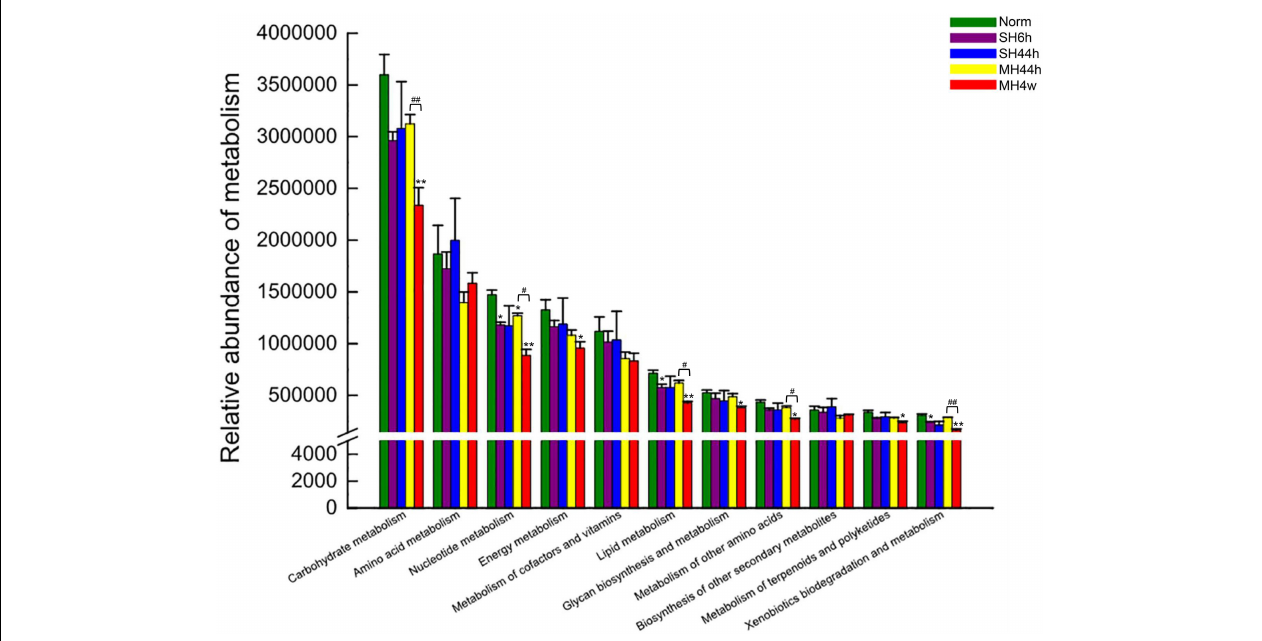
FIGURE 3 | Functional prediction of metabolism between hypoxia treatment groups and normoxia. Bars indicate the mean ± SD. Statistical symbols: * P < 0.05 and ** P < 0.01 between normoxia and hypoxia treatment; # P < 0.05 and ## P < 0.01 between two hypoxic groups under the same oxygen concentration or the same treatment duration.